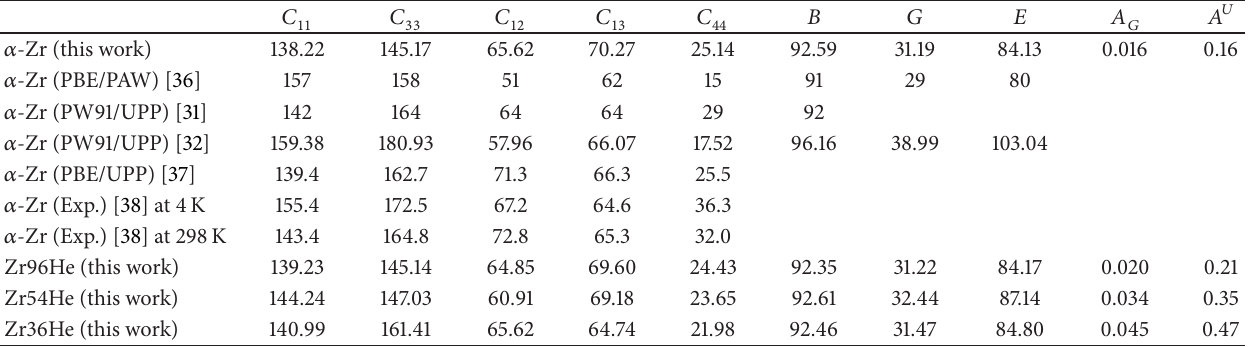
Figure 4: The charge density (𝜌(𝑟)) in a (a) perfect Zr crystal and (b) 54-atom Zr supercell with one Zr atom substituted by a vacancy. The green dotted surfaces are the isosurfaces of 𝜌(𝑟) = 140 e/nm 3 and the slices are the contour plots of the charge density of the basal planes crossing the BO and S sites. Table 3: Elastic constants 𝐶 𝑖𝑗 (in GPa), bulk modulus 𝐵 (in GPa), shear modulus 𝐺 (in GPa), Young’s modulus 𝐸 (in GPa), percentage anisotropy in shear 𝐴 𝐺 , and universal anisotropic index 𝐴 𝑈 of 𝛼 -Zr and Zr-He systems as calculated in the present work compared with experimental